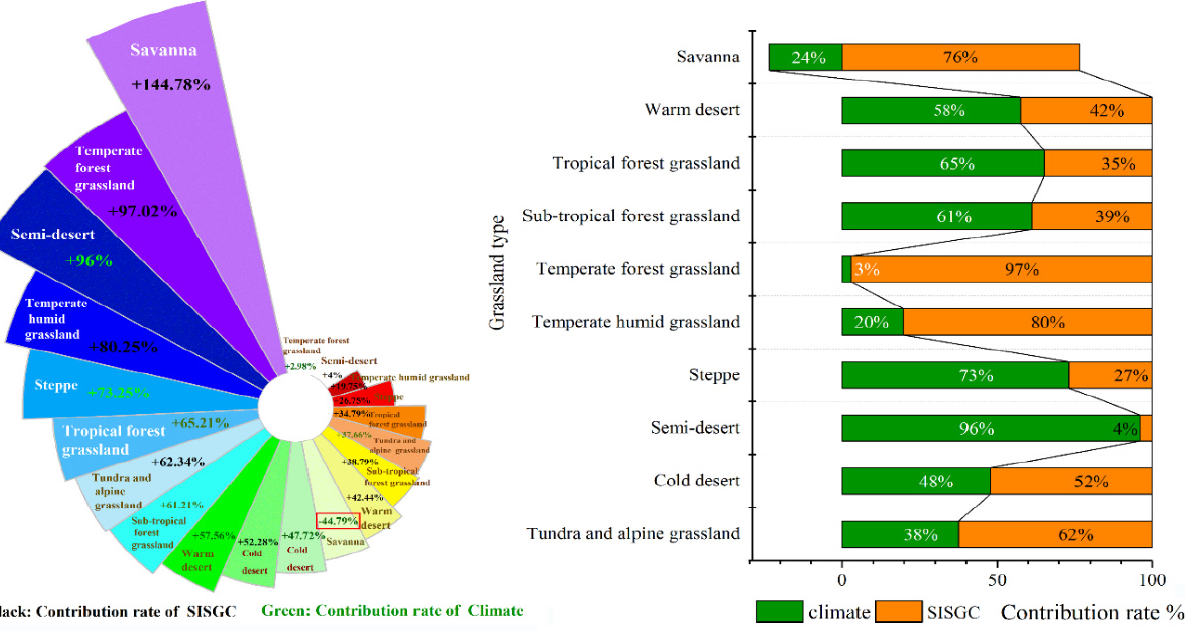
Figure 8. The contribution rate of the policy to the increase of the actual NPP among grassland super-class groups after the implementation of the SISGC.